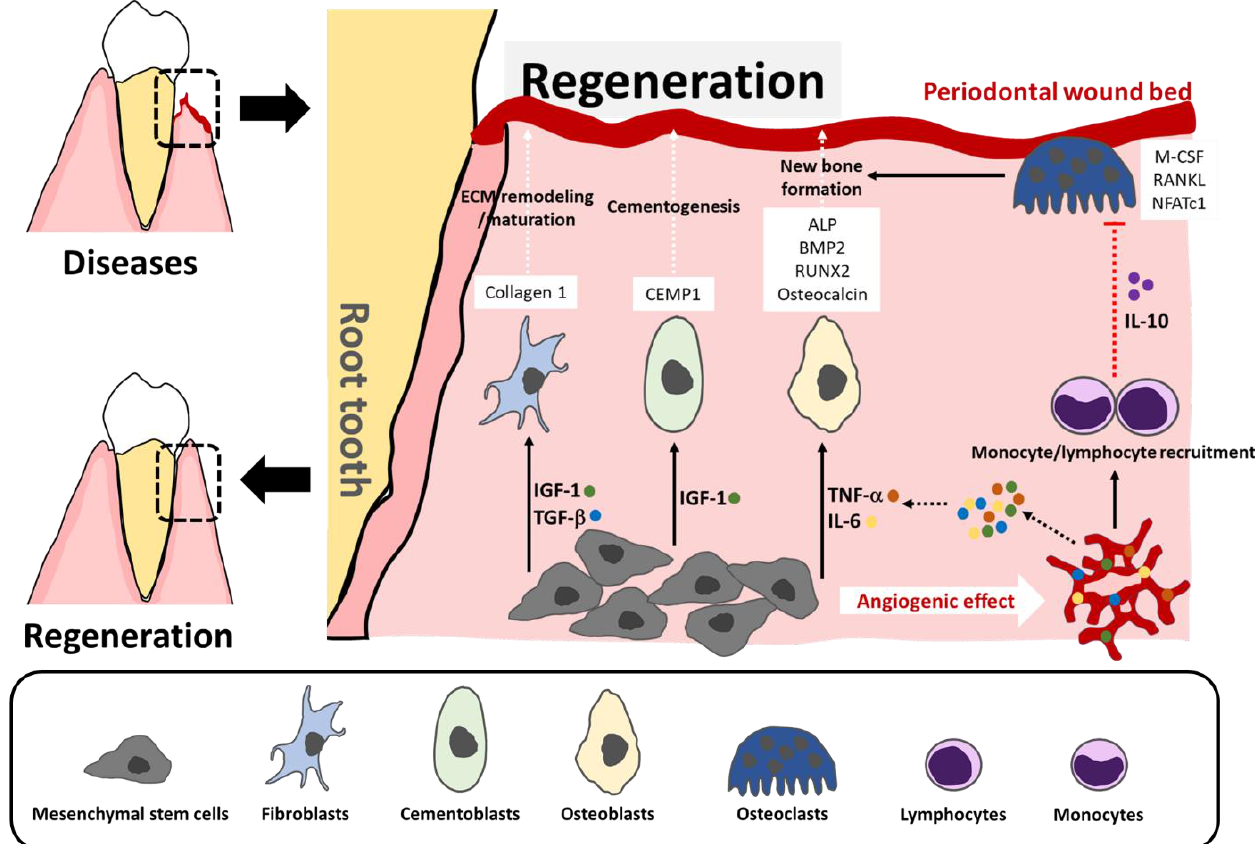
Figure 1 . Mechanisms of periodontal regeneration . MSC at the area of lesions exerts angiogenic ef- fects, resulting in the secretion of inflammatory cytokines ( TNF - a and IL - 6 ) and growth factors ( IGF - 1 and TGF - b ) , and recruitment of immune cells ( monocytes and lymphocytes ). These inflammatory mediators induce proliferation and differentiation of MSC towards fibroblasts, cementoblasts, and osteoblasts leading to ECM remodeling, cementogenesis, and new bone formation, respectively . The immune cells release IL - 10 to suppress osteoclast activation in homeostatic maintenance of new bone formation